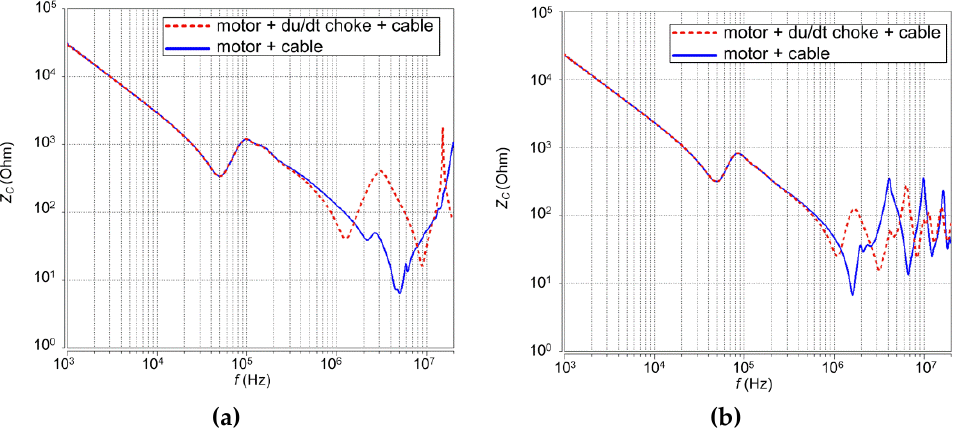
Figure 15. Measured impedance Z C (f) frequency characteristics: ( a ) motor + du/dt choke ( L DT = 0.31 mH) + 1 m cable; ( b ) motor + du/dt choke ( L DT = 0.31 mH) + 10 m cable.